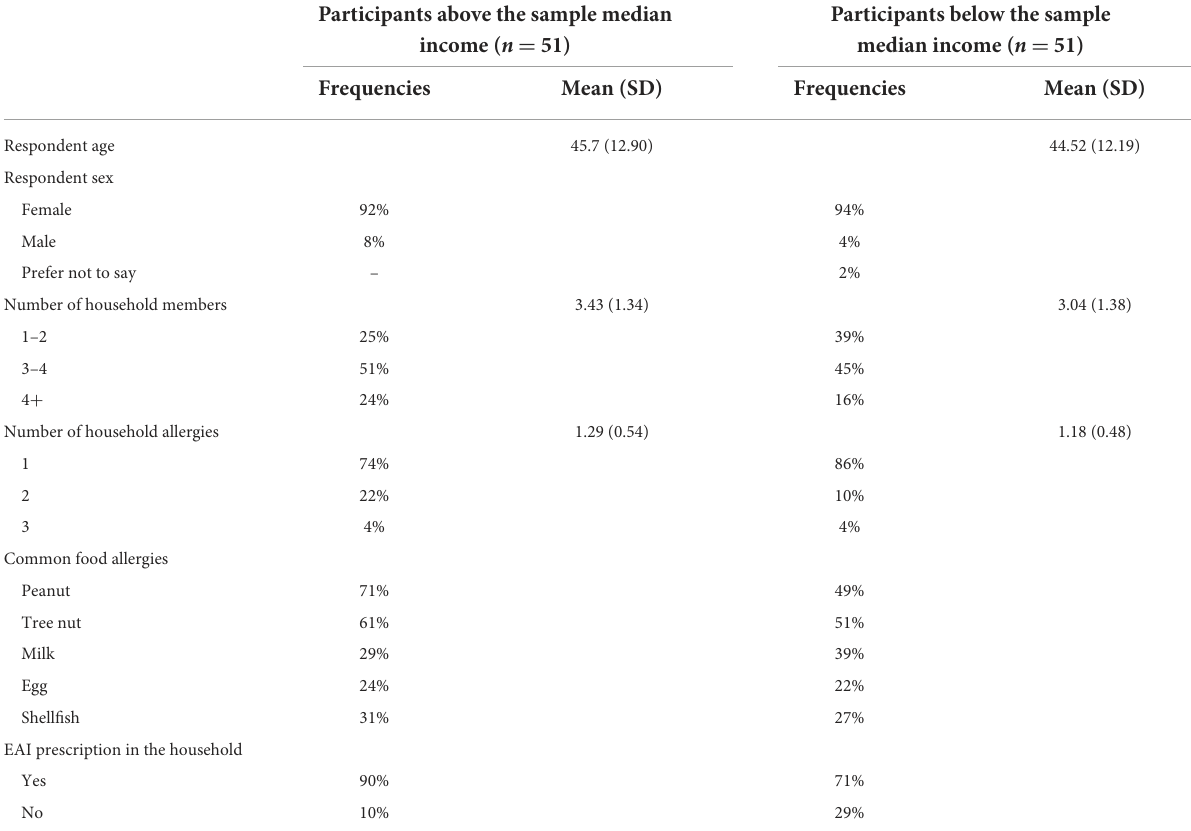
TABLE 1 Participant characteristics. Participants above the sample median